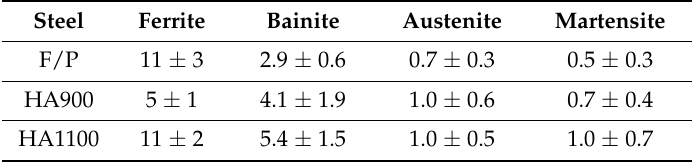
Table 3. Characteristic dimensions for each steel [ µ